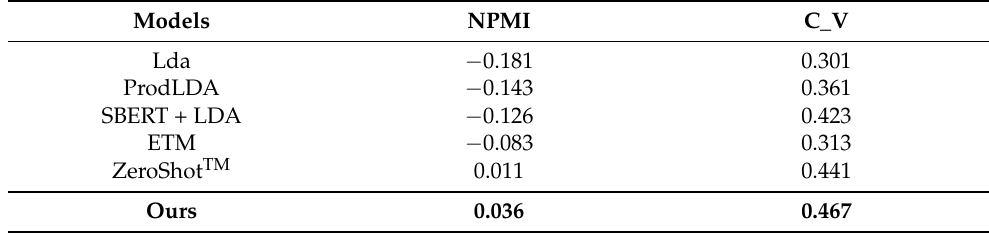
Table 2. Comparison of the topic coherence (NPMI and C_V values) of different models.